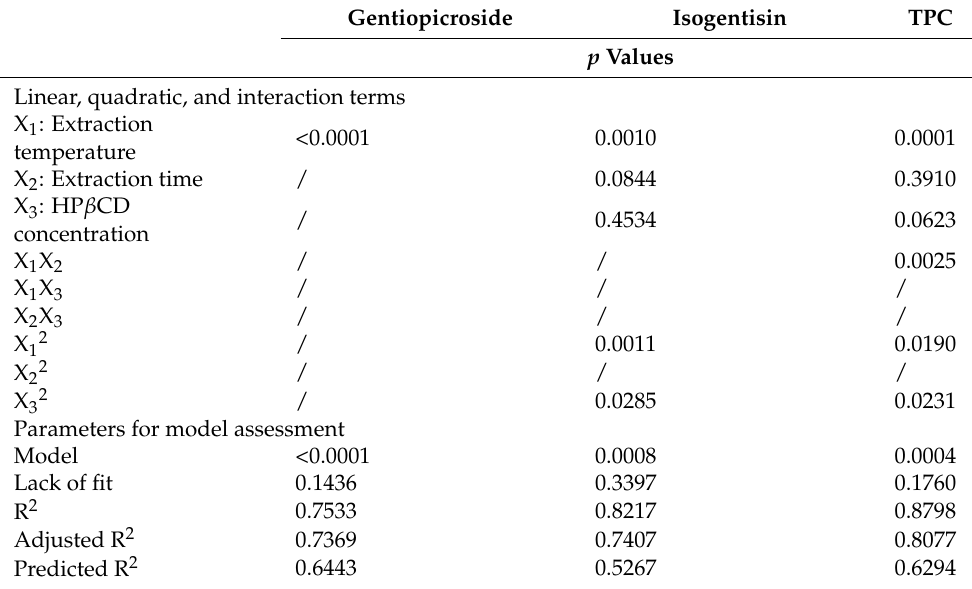
Table 2. Estimated regression coefficients and analysis of the variance of the fitted second-order polynomial models for the investigated